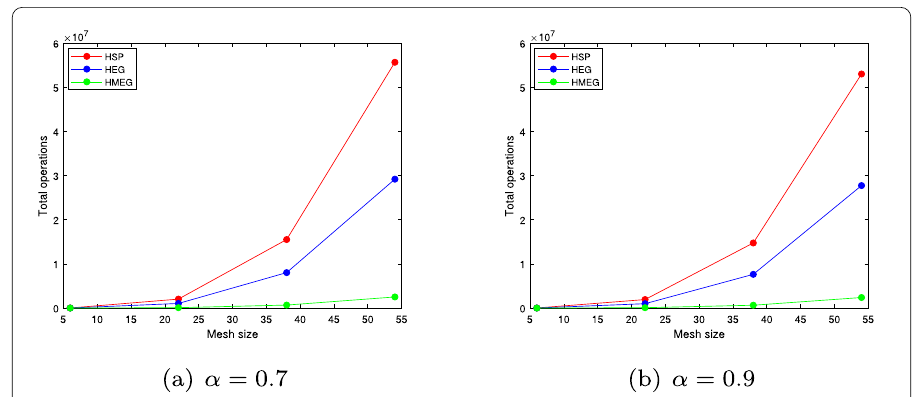
Figure 9 The total arithmetic operations plot of the HSP, HEG and HMEG methods for Example 5.2